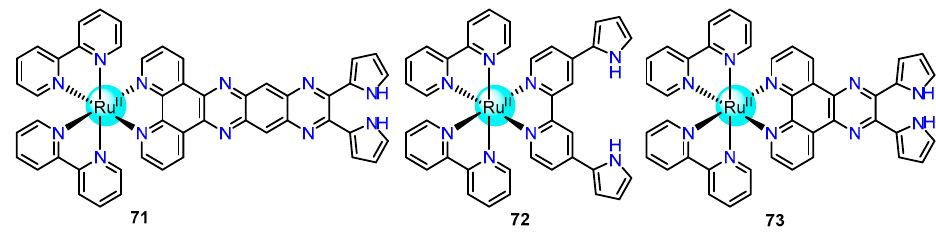
Figure 11. Structures of dipyrrol-based Ru(II) complexes 71 – 73.